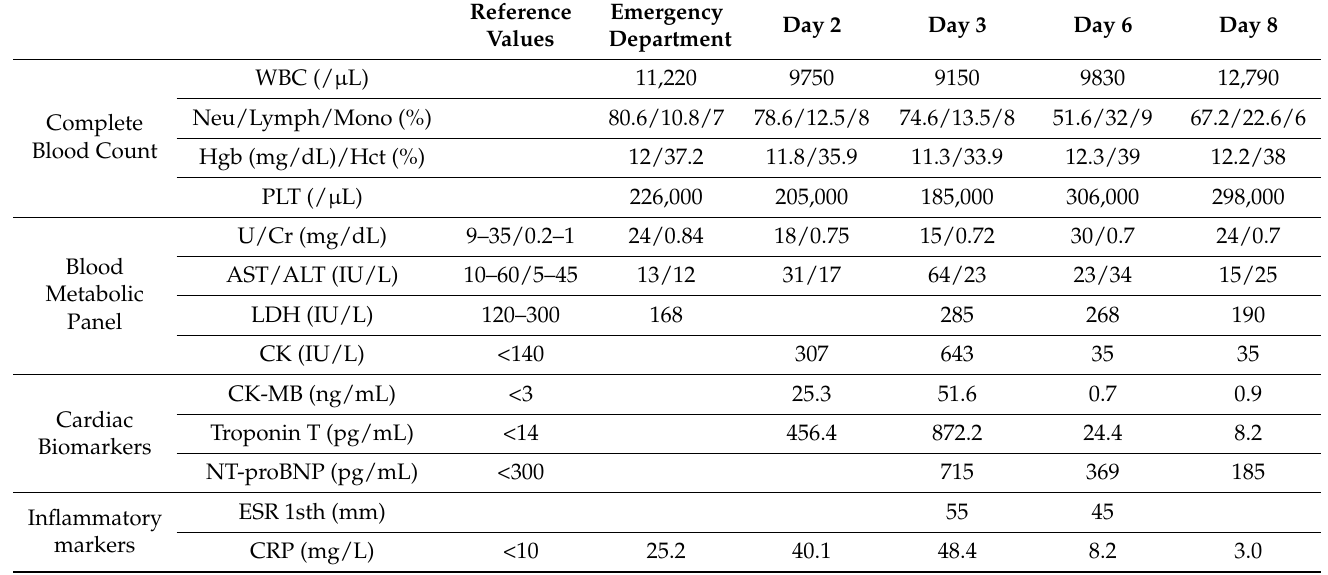
Table 1. Laboratory parameters and cardiological